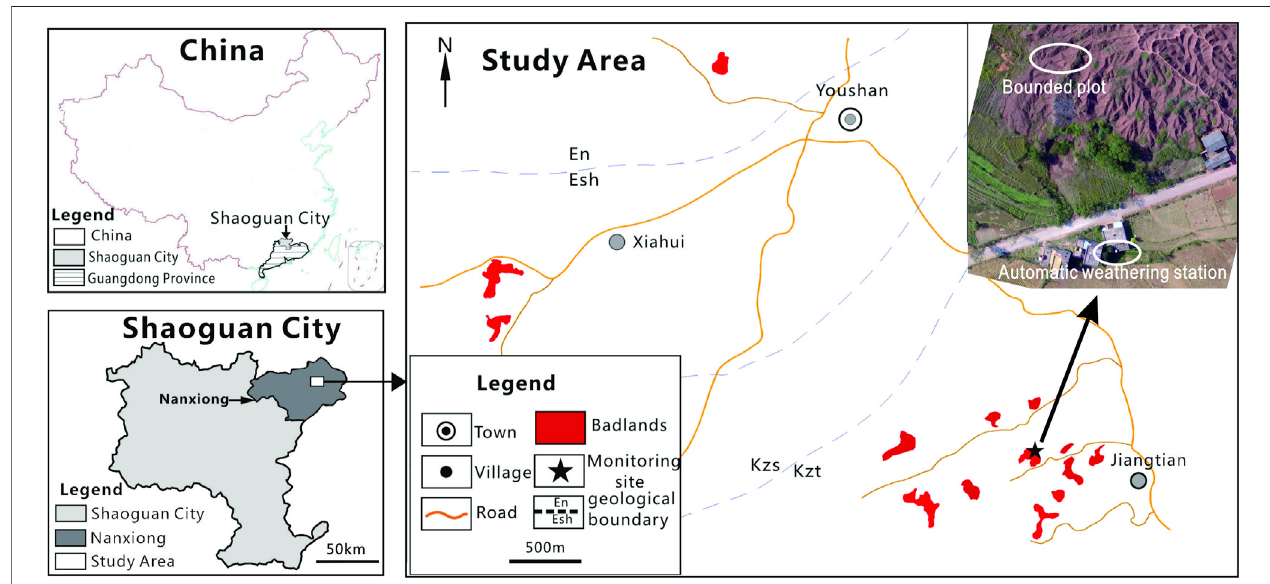
FIGURE 1 | Map of Nanxiong Basin in Guangdong Province and the Monitoring site.